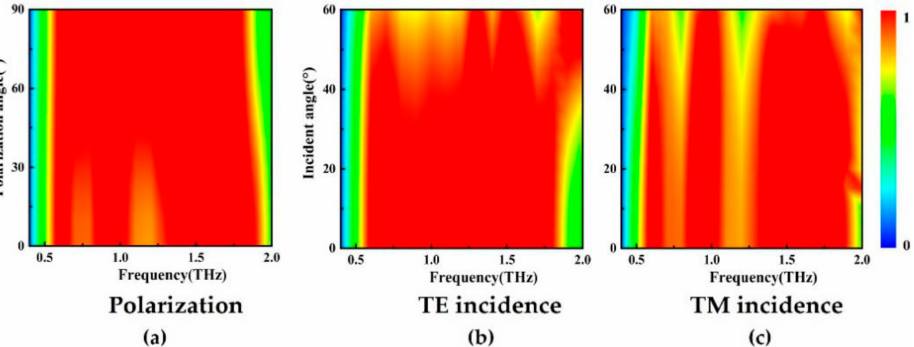
Figure 8. Numerical simulation of the polarization and oblique incidence of the supercell absorber. ( a )Absorption spectra with different polarization angles ( Φ = 0–90 ◦ ), the polarization angles range from TE polarization (0 ◦ ) to TM polarization (90 ◦ ). ( b , c ) 0 to 60 ◦ oblique incident angle for TE incidence and TM